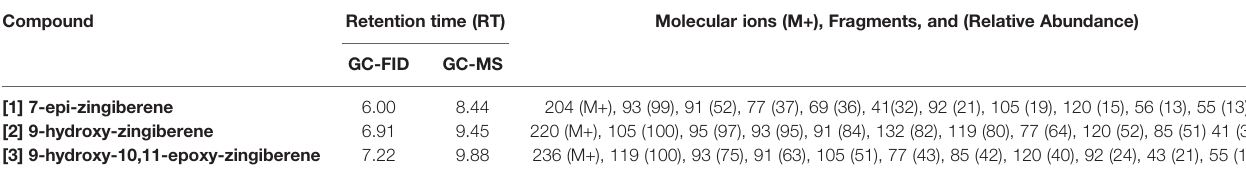
TABLE 2 | GC-FID and GC-MS retention times, molecular ion (M+) and characteristic mass fragments of the three allelochemical components extracted from wild tomato accessions Solanum habrochaites (LA2329, PI127826, and LA2167).